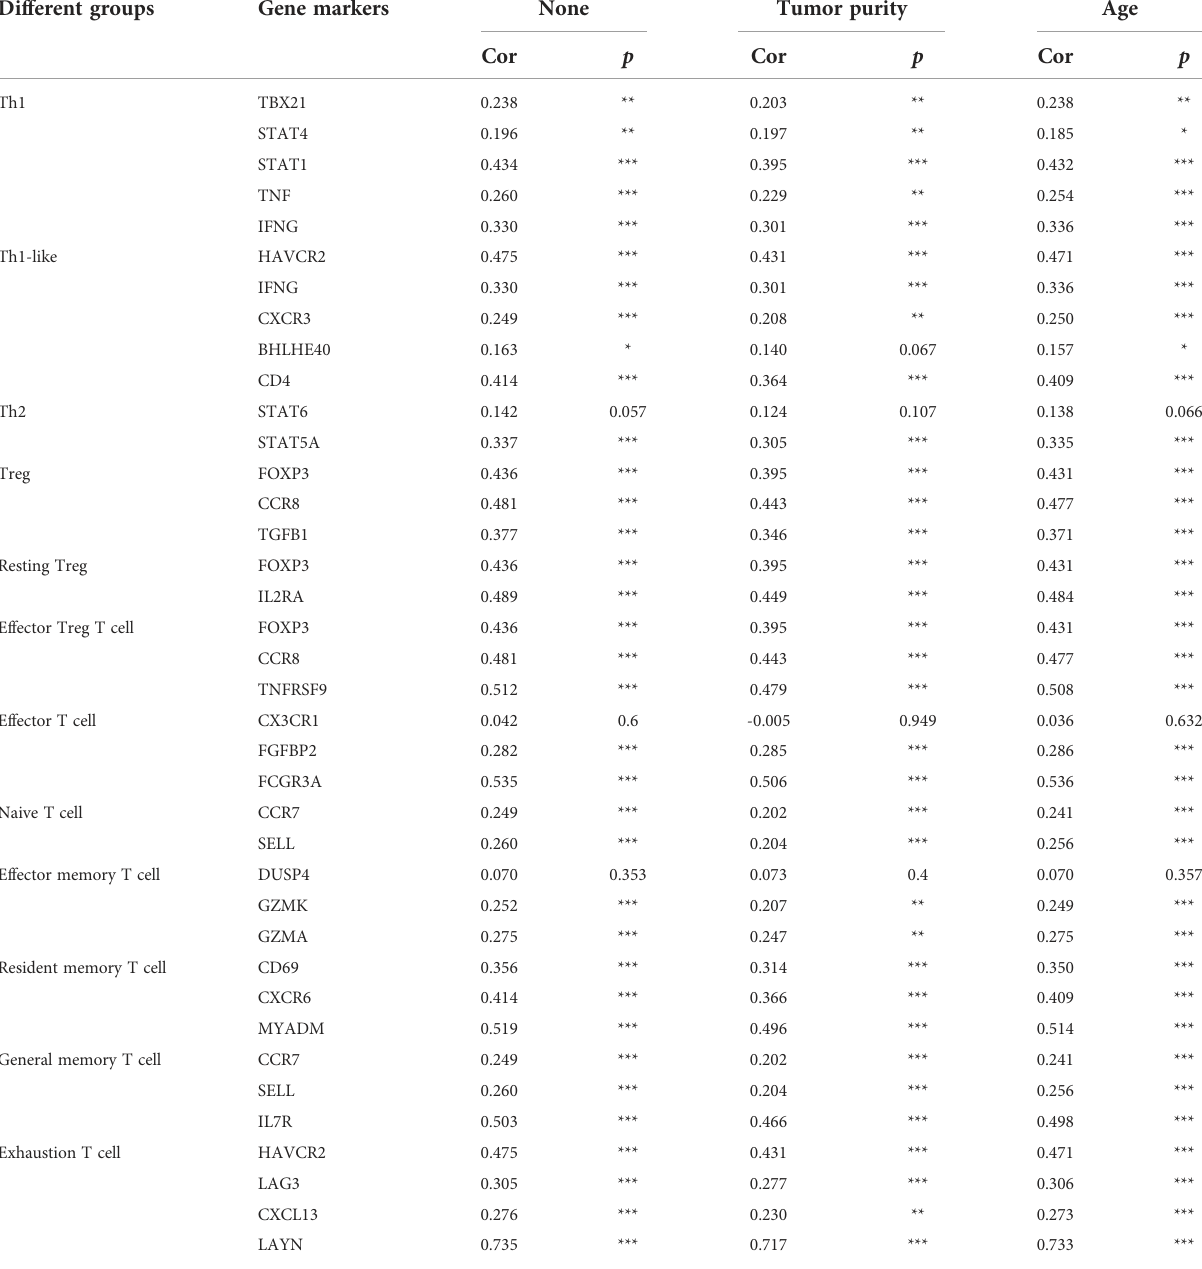
TABLE 2 Correlation analysis between GREM1 and gene markers of different subgroups of T cells in PDAC by TIMER analysis. Different groups Gene markers None Tumor purity